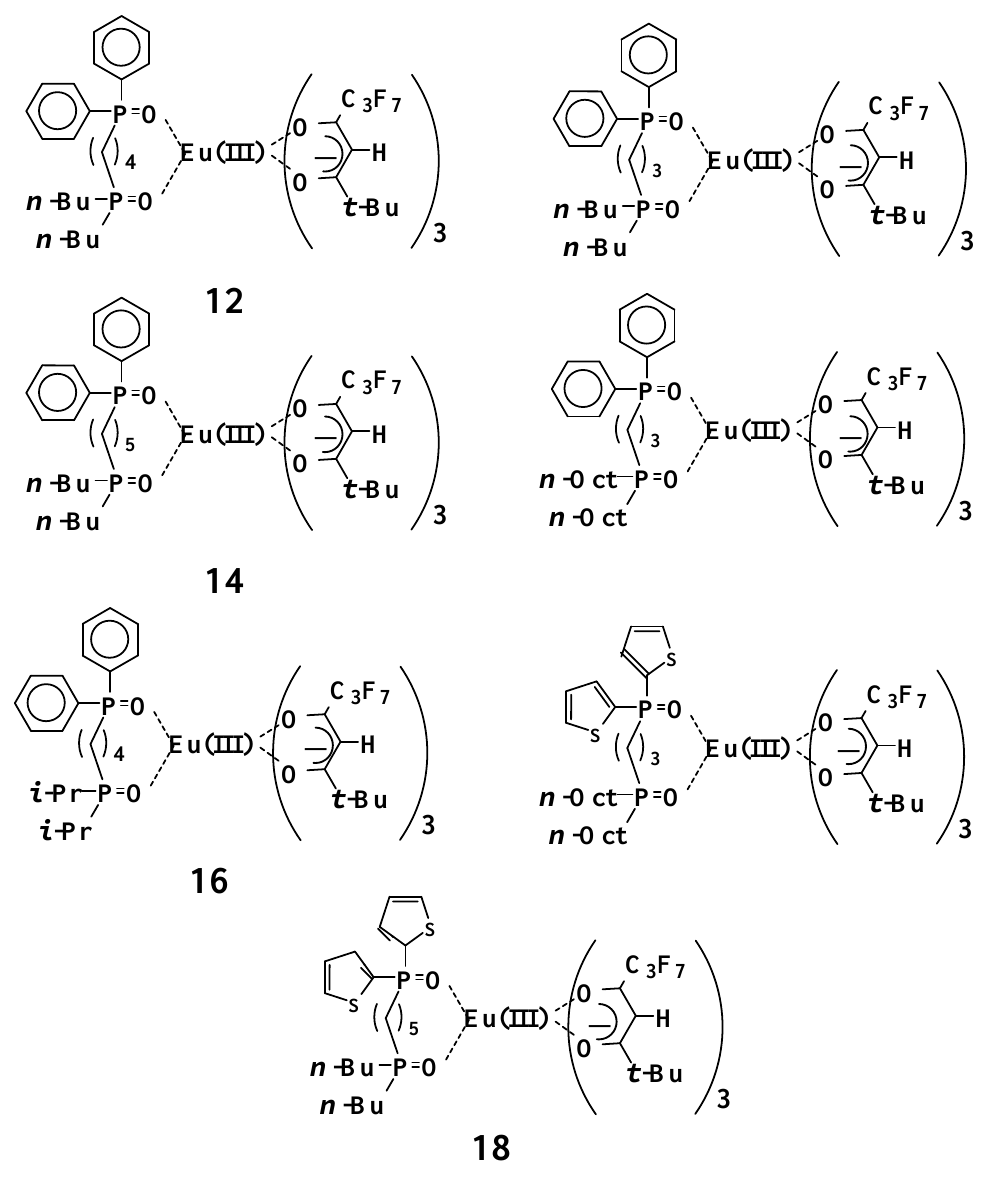
Figure 11. Molecular structures of Eu(III) complexes with non-symmetric bis-phosphine